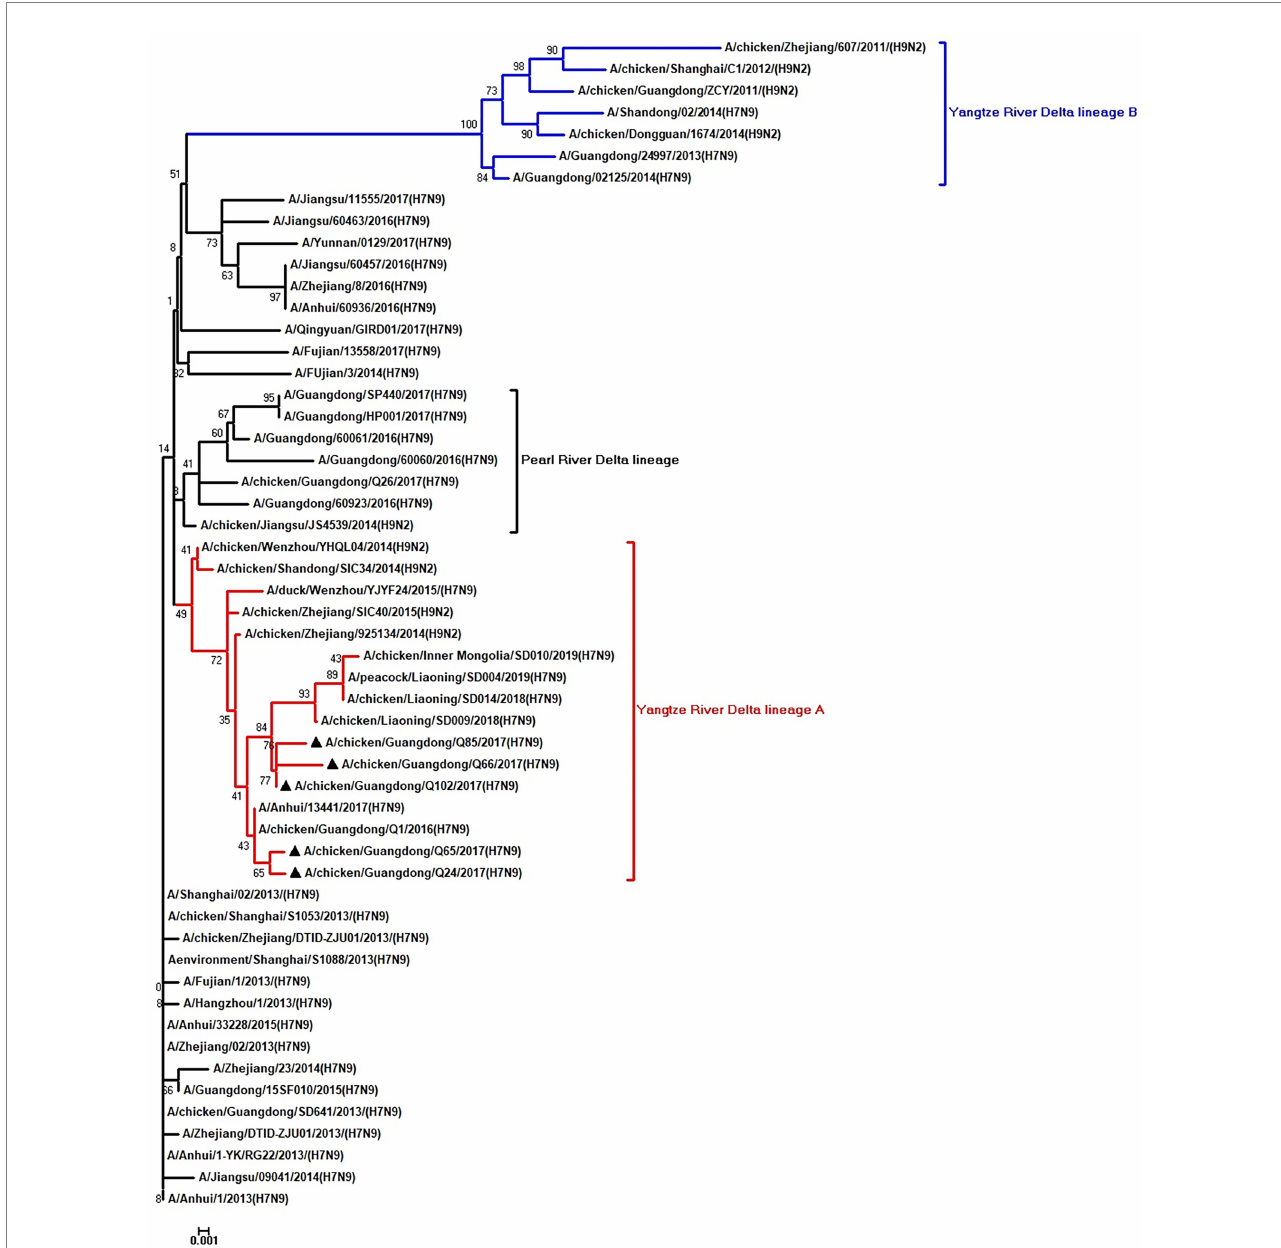
FIGURE 5 Phylogenetic analysis of NS. The tree was constructed by using the neighbor joining method with the Maximum Composite Likelihood model and MEGA version 5.2 (www.megasoftware.net/) with 1,000 bootstrap replicates based on the following sequences: NS: nt 27–680. Except our five isolates, other virus sequences were downloaded from GenBank. Triangles indicate the viruses characterized in this study. The scale bar indicates the branch length and corresponds to 0.001 estimated amino acid substitutions per